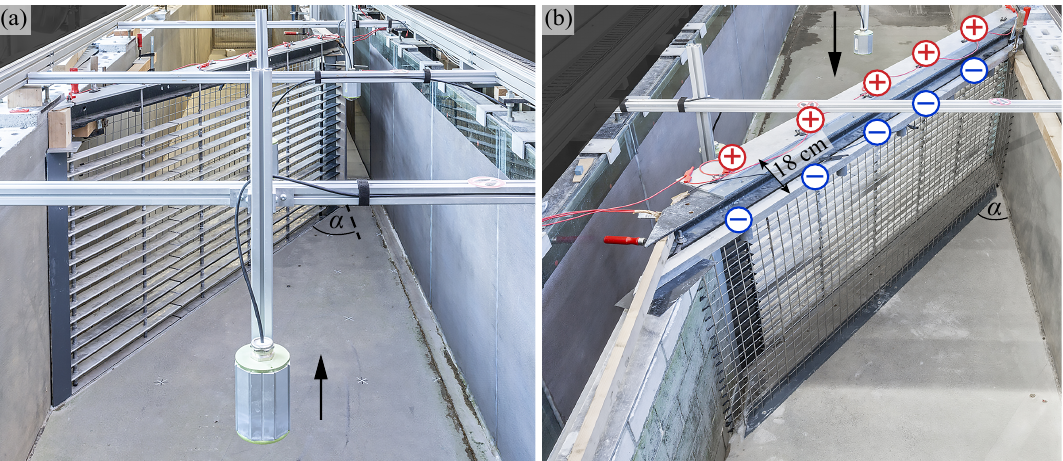
Figure 1. Electrification of the horizontal bar rack with s b = 51 mm ( a ) in flow direction and ( b ) against flow direction with the rack as the anode (+) and the metal mesh as the cathode ( − ), and the horizontal approach flow angle α